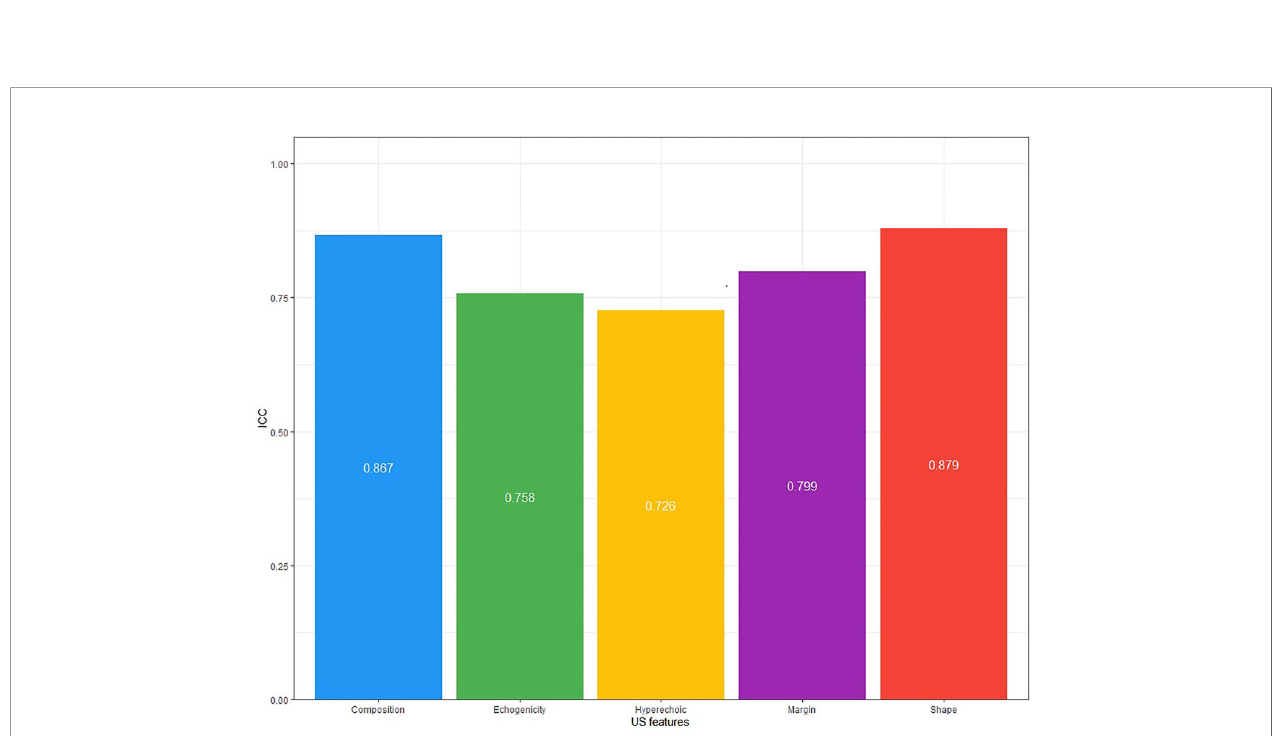
FIGURE 3 | The ICC values of Ultrasound